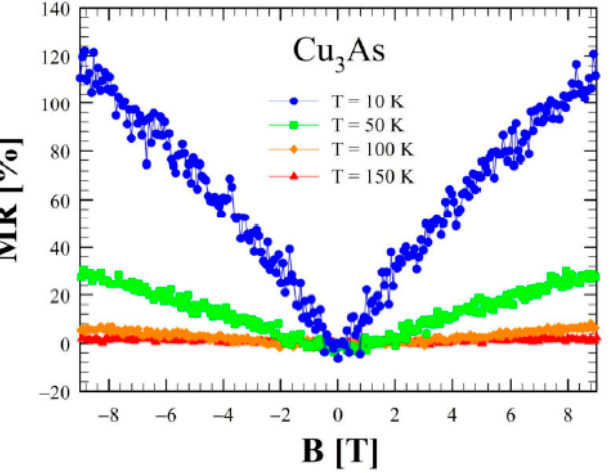
Figure 16. Magnetoresistance as a function of applied magnetic field between 0 and ± 9 T at several temperatures (10 K, 50 K, 100 K and 150 K) for Cu 3 As.